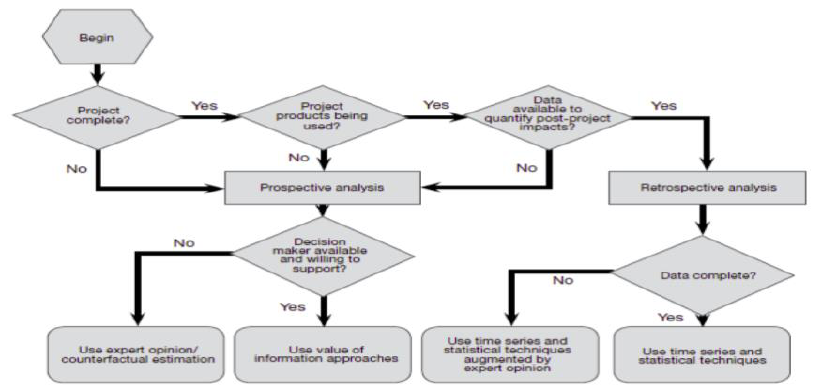
Figure 2: Flowchart in Choosing a Research Approach; Source: Processed